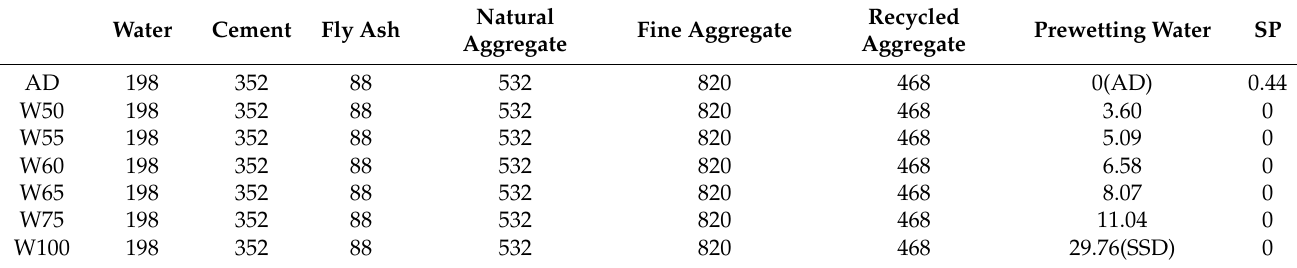
Table 3. Mix proportion of recycled concrete (kg/m 3